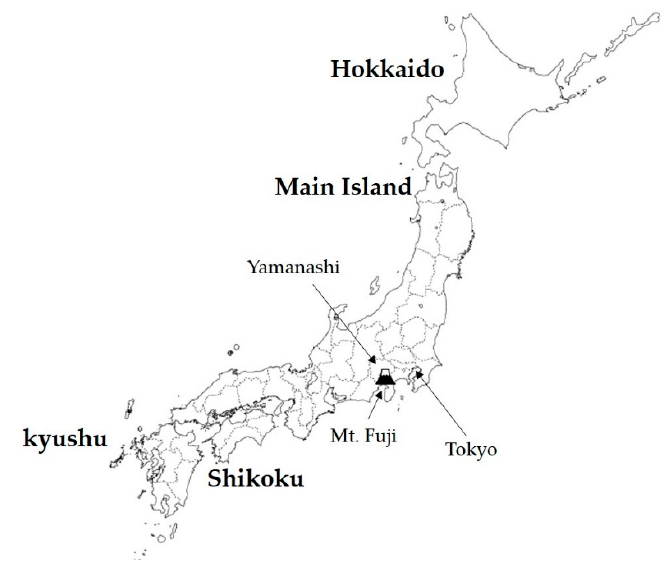
Figure 2. Japanese Archipelago and location of Yamanashi Prefecture.